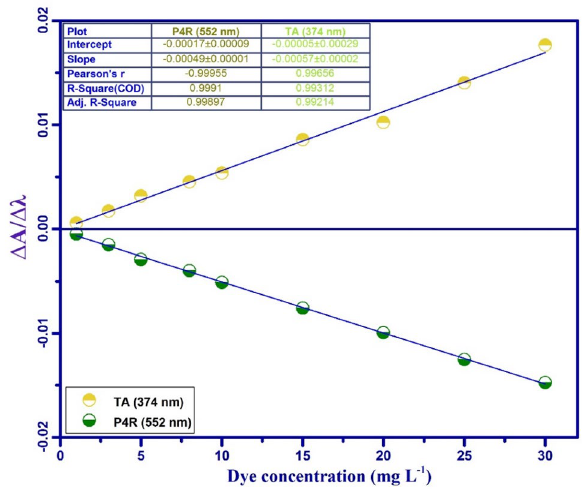
Figure 3. Calibration curve of TA (374 nm) and P4R (552 nm) dyes.